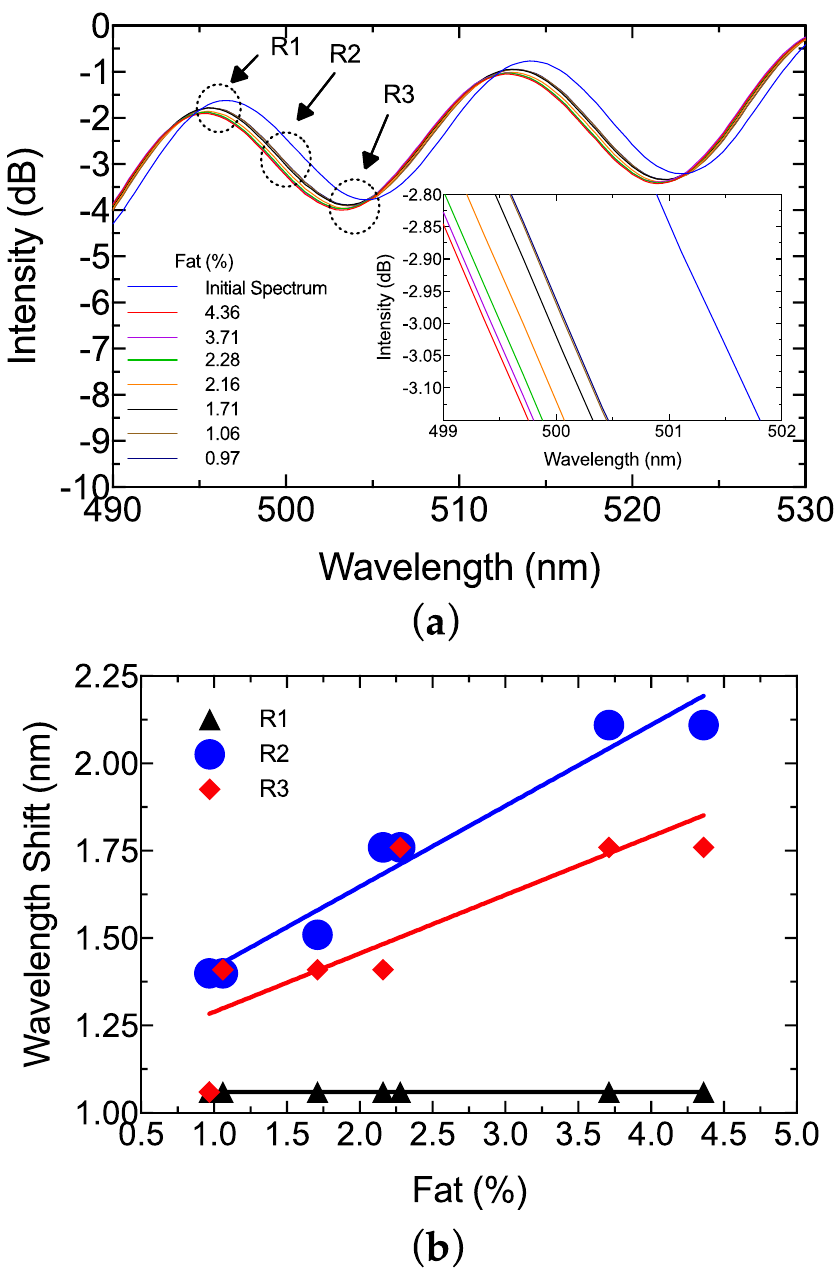
Figure 6. ( a ) Interference spectrum response for total fat variation. Inset is a zoomed view of the middle region (R2). ( b ) Wavelength shift analysis of the three regions with linear regression.